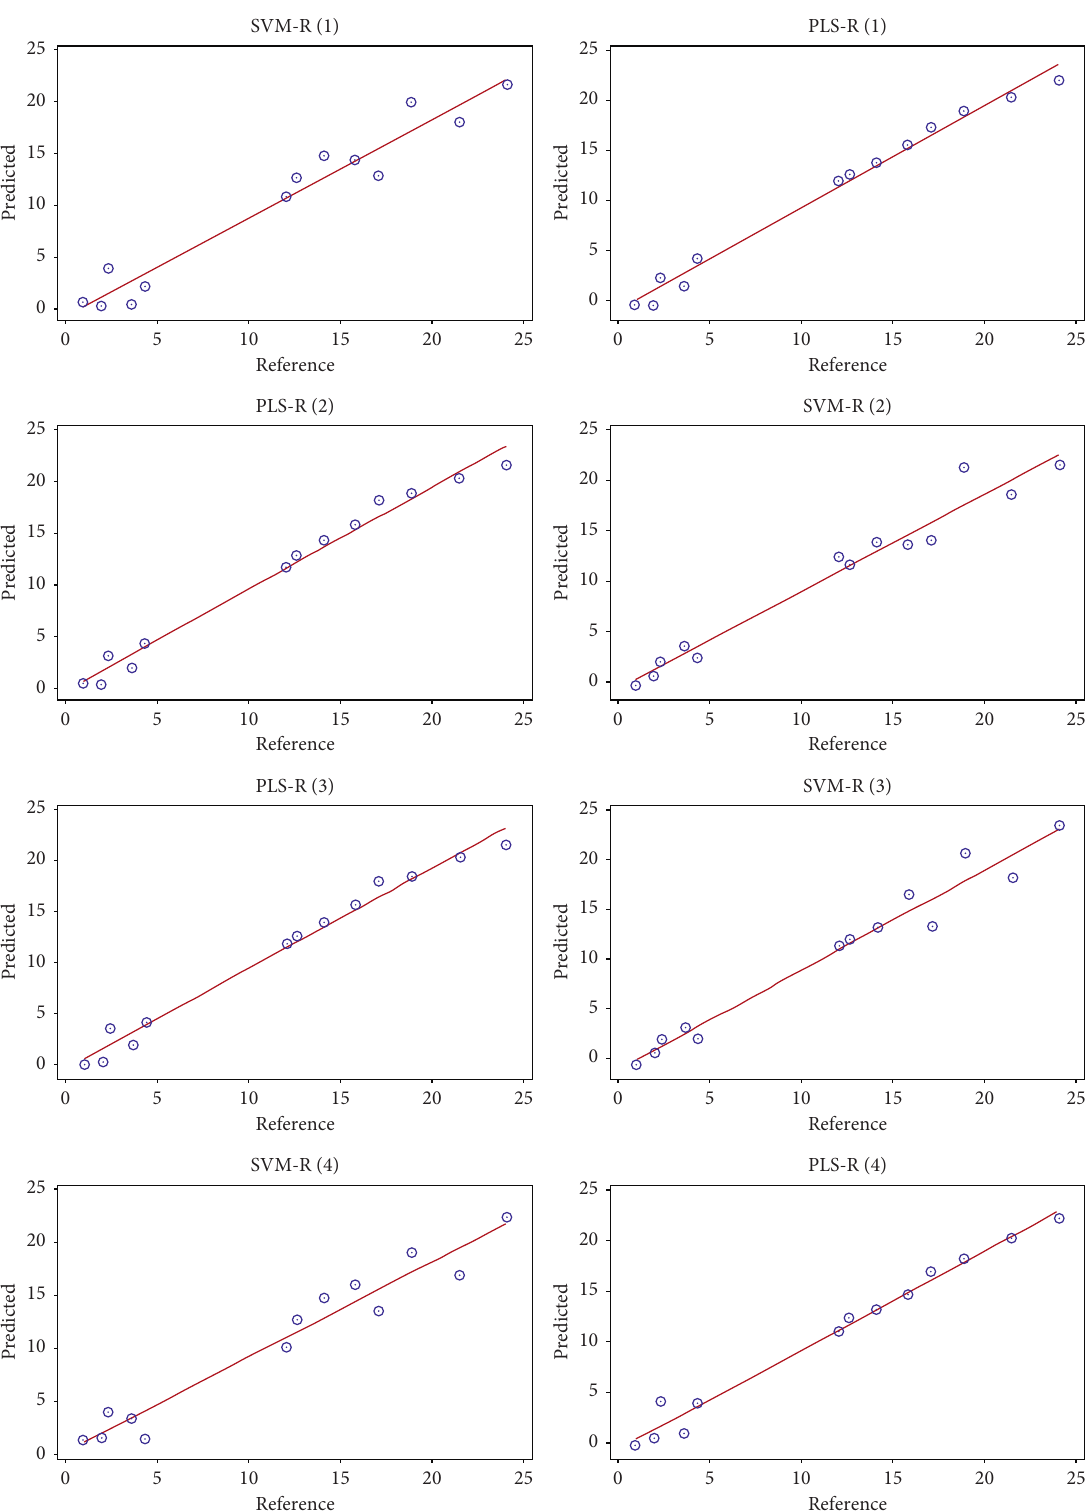
Figure 6: Results of the external validation by PLS-R and SVM-R of the different models built, representing the predicted values according to the reference